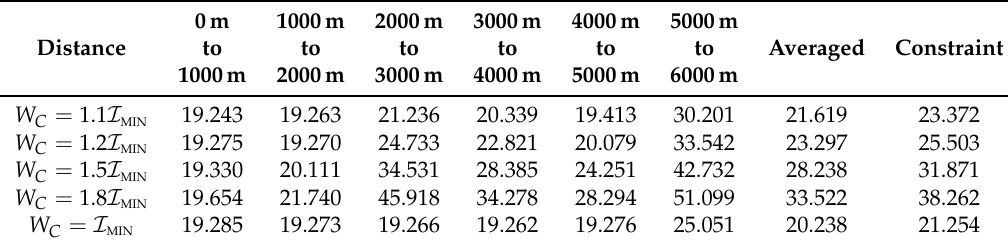
Table 6. Average current consumption results according to distance between the LoRa GW and each ED. Unit for all values is mAh.